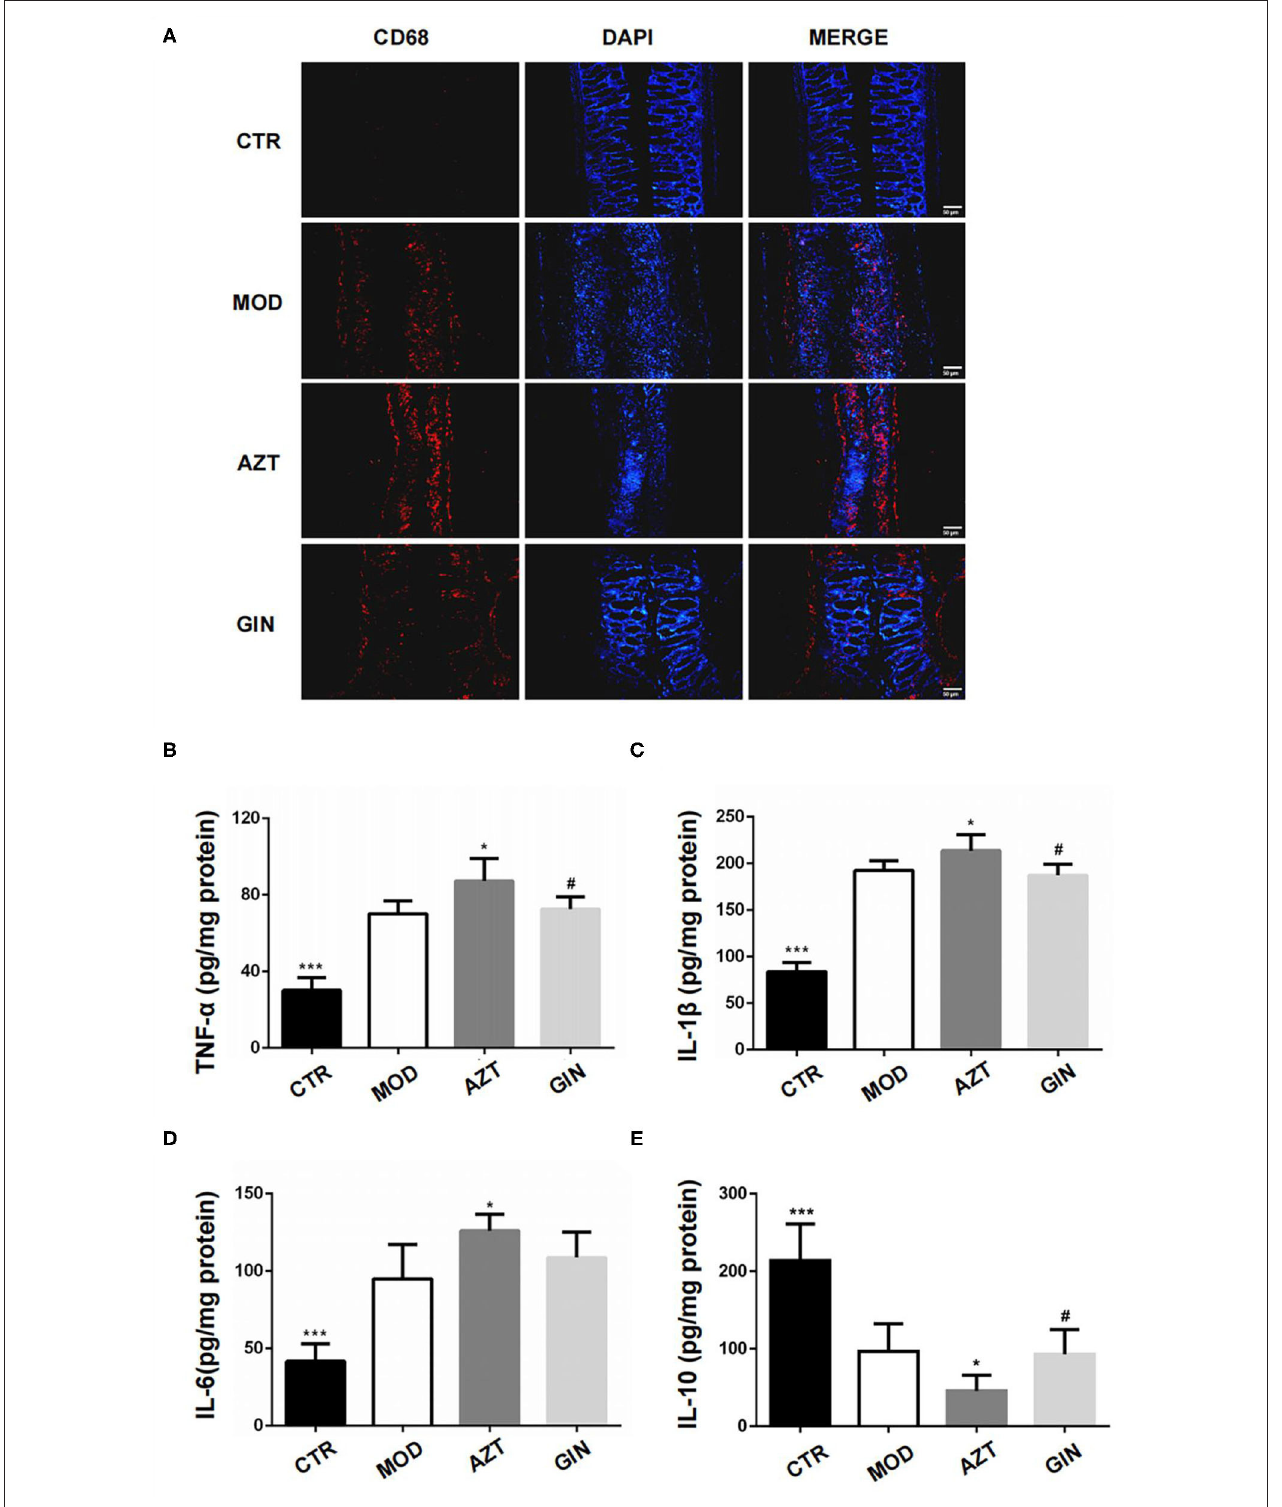
FIGURE 4 | Ginger inhibits inflammatory response in DSS-induced colitis mice exposed to AZT in early life. (A) Representative images of immunofluorescence of CD68-positive macrophages in colon sections. (B–E) Colonic cytokine levels of TNF- α , IL-1 β , IL-6, and IL-10. Data represent means ± SD ( n = 5). * p < 0.05 and *** p < 0.01 vs. MOD group; # p < 0.05 vs. AZT